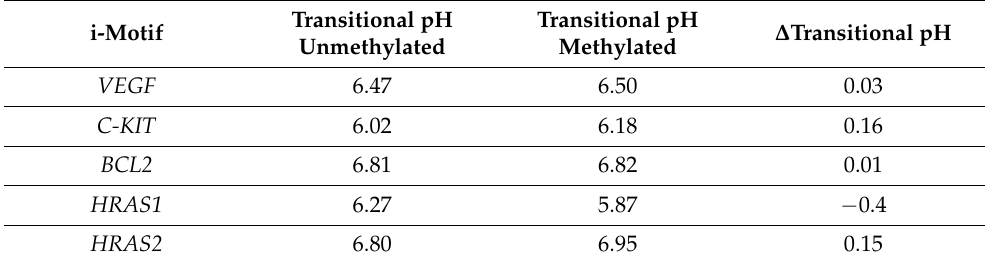
Table 1. Transitional pH of unmethylated and methylated VEGF , C-KIT , BCL-2 , HRAS1, and HRAS2 i-motifs. CpG methylation increased the transitional pH of several i-motif-forming